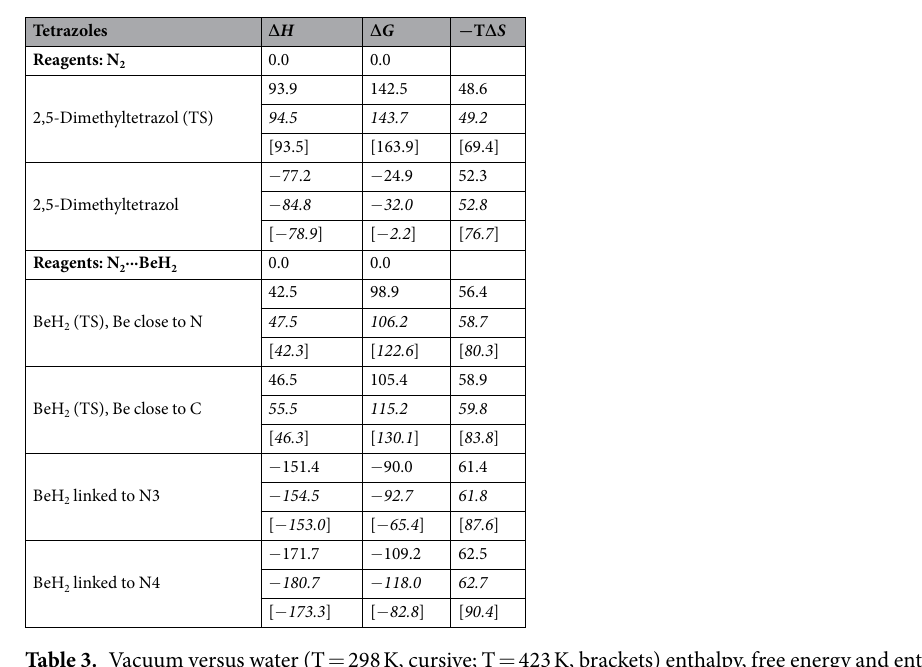
Table 3. Vacuum versus water (T = 298 K, cursive; T = 423 K, brackets) enthalpy, free energy and entropy contributions (kJ.mol –1 ) for the 1,3-dipolar cycloaddition between dimethyl nitrile imine, and N 2 and H 2 Be···N 2 as dipolarophiles at the G4MP2 level (T = 298.15 K). Dimethyl nitrile imine is omitted as a reagent for the sake of